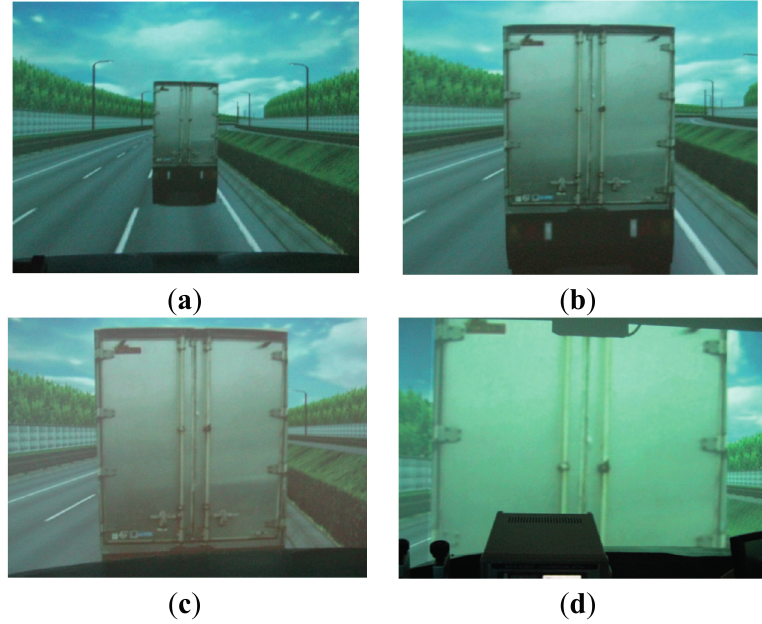
Figure 5. Preceding vehicles with the different gap distances. ( a ) 25 m gap distance; ( b ) 12 m gap distance; ( c ) 8 m gap distance; ( d ) 4 m gap